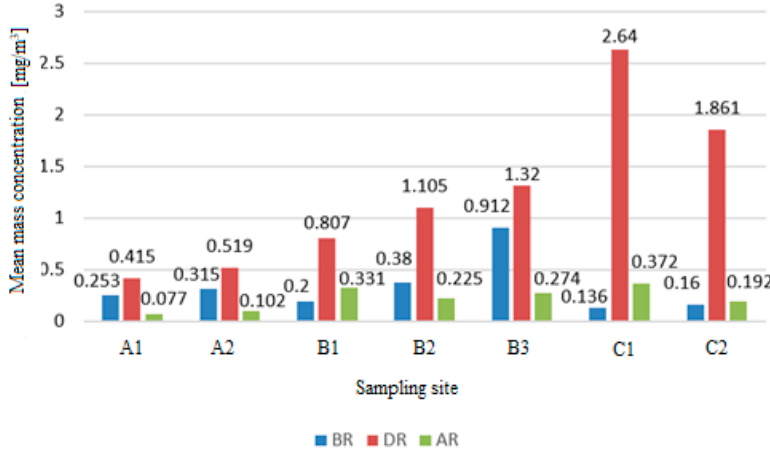
Figure 8. Mean values of mass concentrations of asbestos dust on the work posts in the building during, and after removal of before, during, and after removal of ACPs.